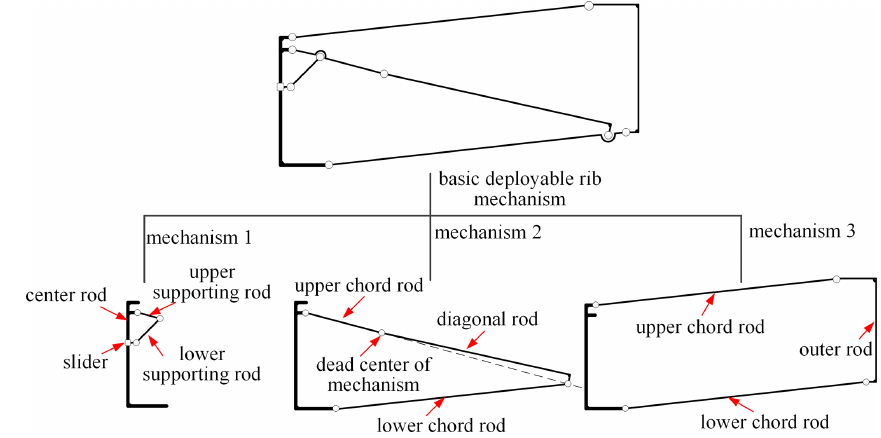
Figure 4. Decomposition of basic rib mechanism.